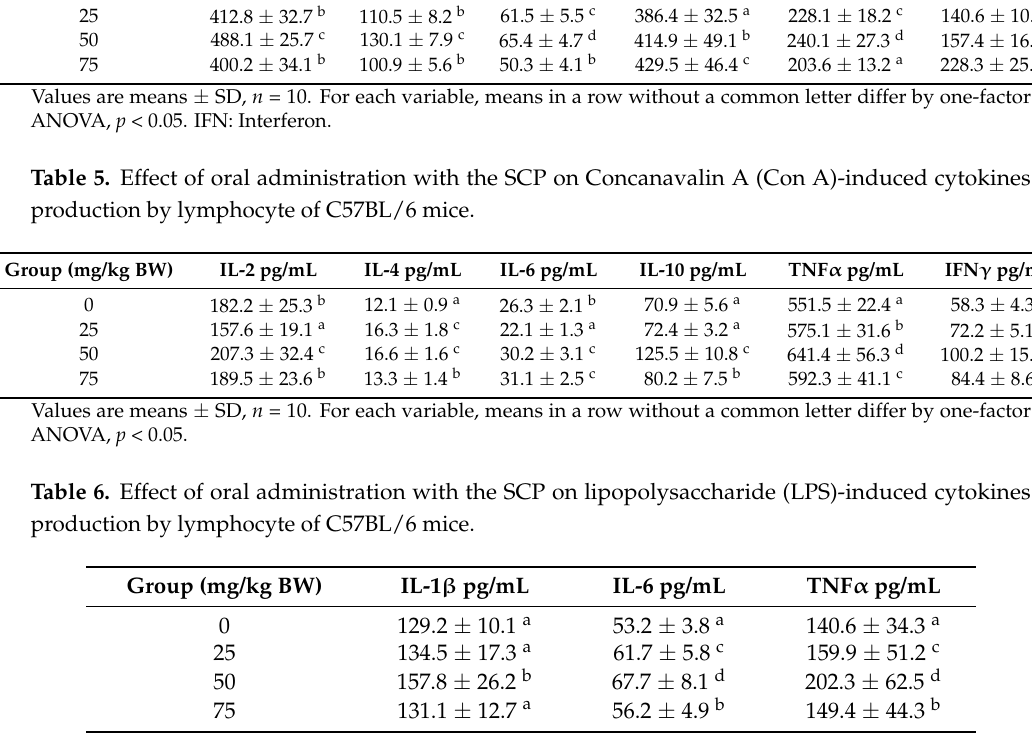
Table 4. Effect of oral administration with the SCP on CD3/CD28-induced cytokines production by lymphocyte of C57BL/6 mice.